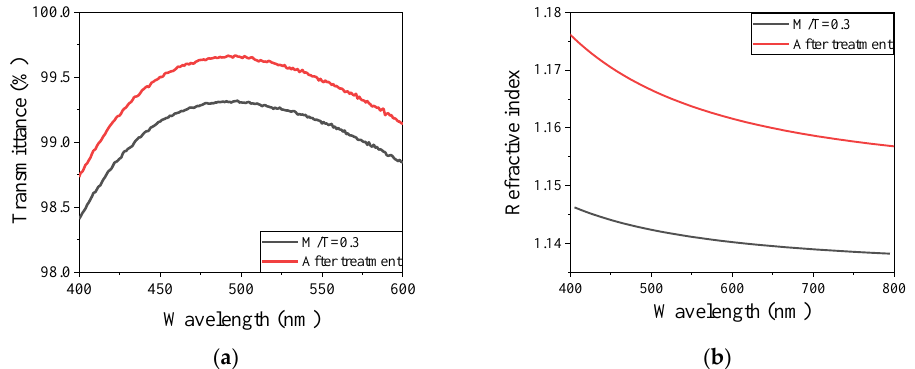
Figure 2. The transmittance spectra ( a ) and refractive index ( b ) of untreated film (M/T = 0.3) and the film after treatment. Table 1. Changes in the refractive index and thickness of M/T ratio film after vapor treatment. Refractive Index ( n ) Thickness ( d ) M/T Ratio